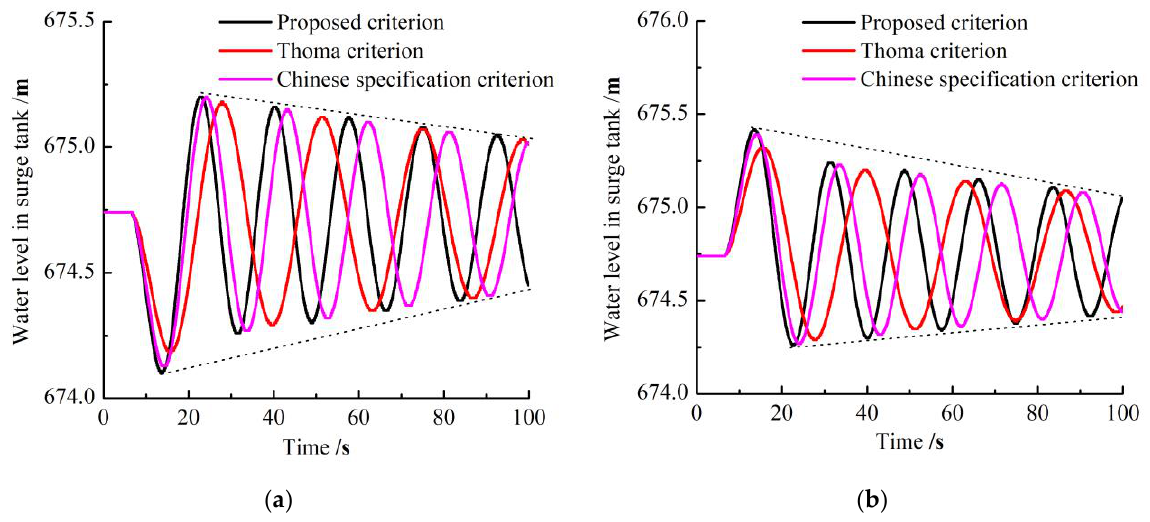
Figure 9. WLO process of the headrace ST in case 2: ( a ) Working condition 1. ( b ) Working condition 2. Table 5. Extreme values and periods of WLO in the headrace ST.